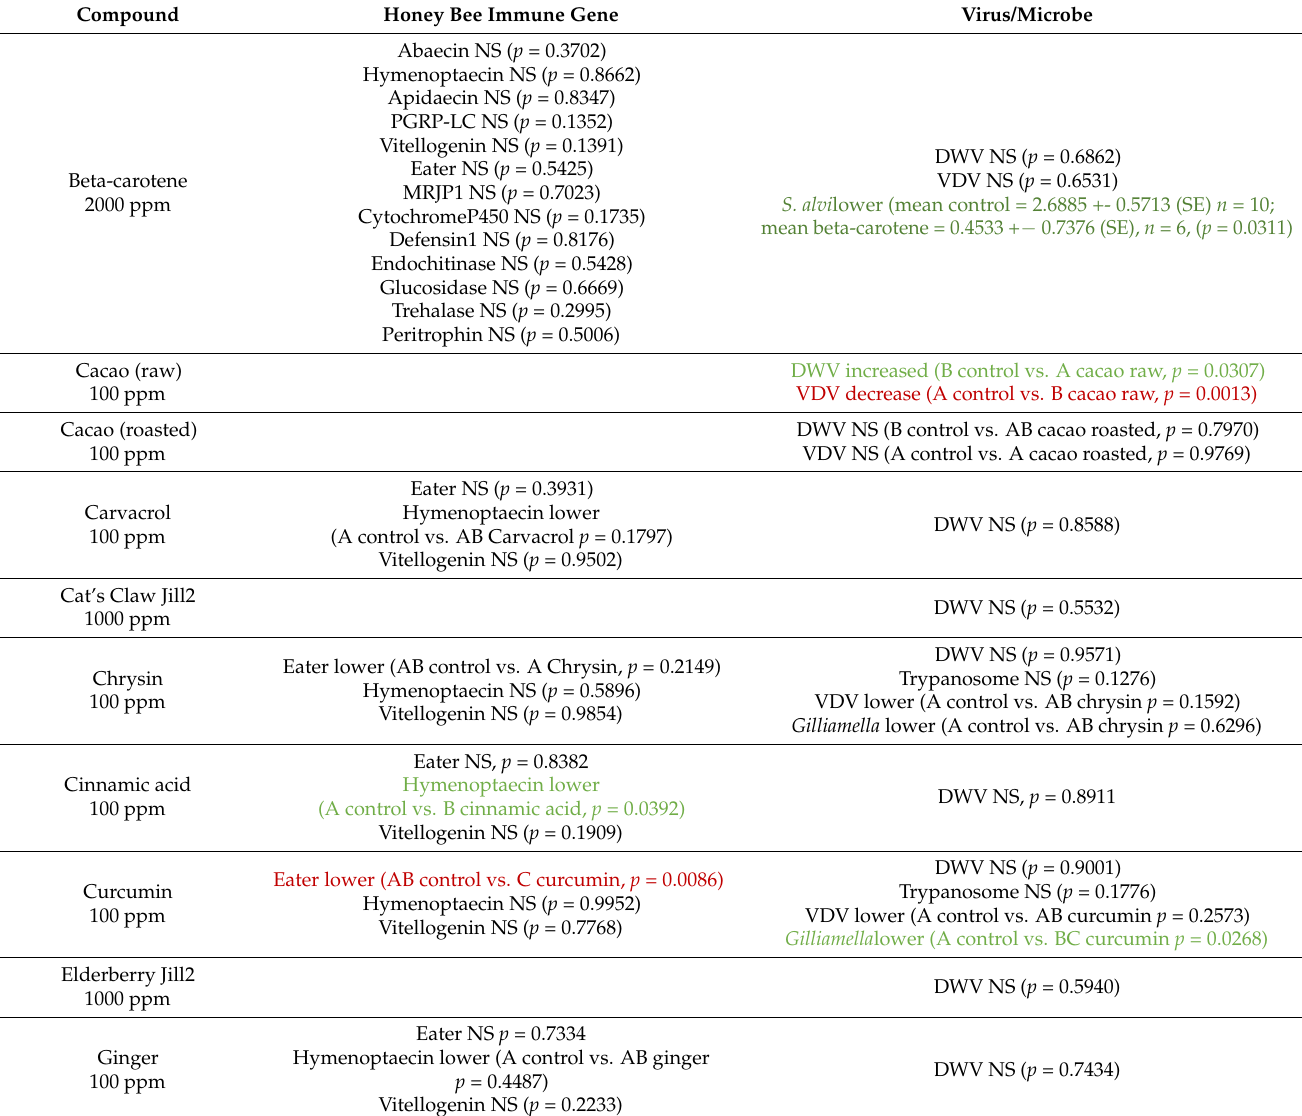
Table 2. Overview of natural product or compound tested and observed effects. Gene expression (up- or downregulated) of a target gene or virus/microbe detection was relative to the sugar water control for that experiment. NS = no significant change; grey = p < 0.1; green = p < 0.05; red = p < 0.01. Compound Honey Bee Immune